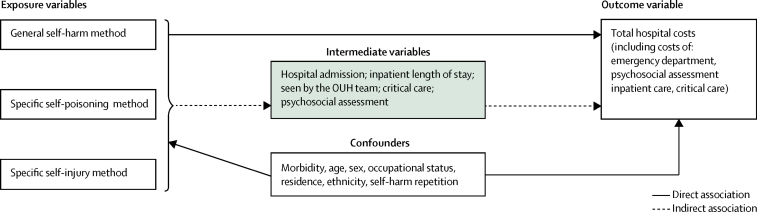
Association between self-harm and total hospital costsOUH=Oxford University Hospital.